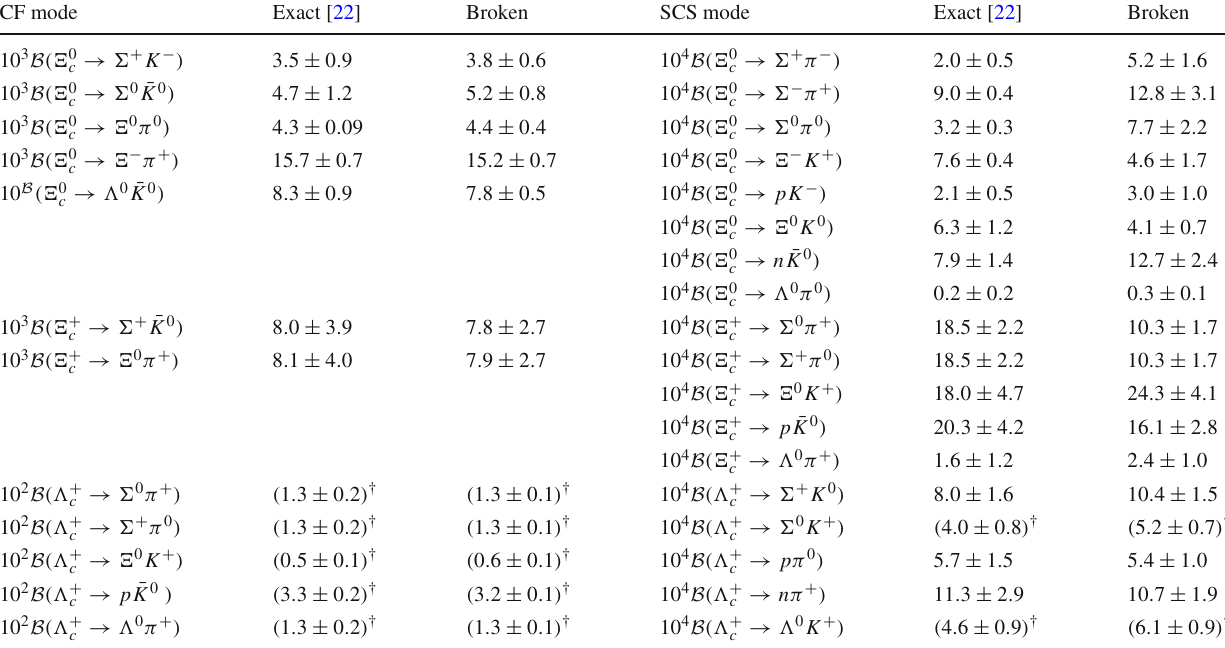
Table 3 The branching ratios of the B c → B n M decays, where the numbers with the dagger (†) correspond to the reproductions of the experimental data input, instead of the predictions CF